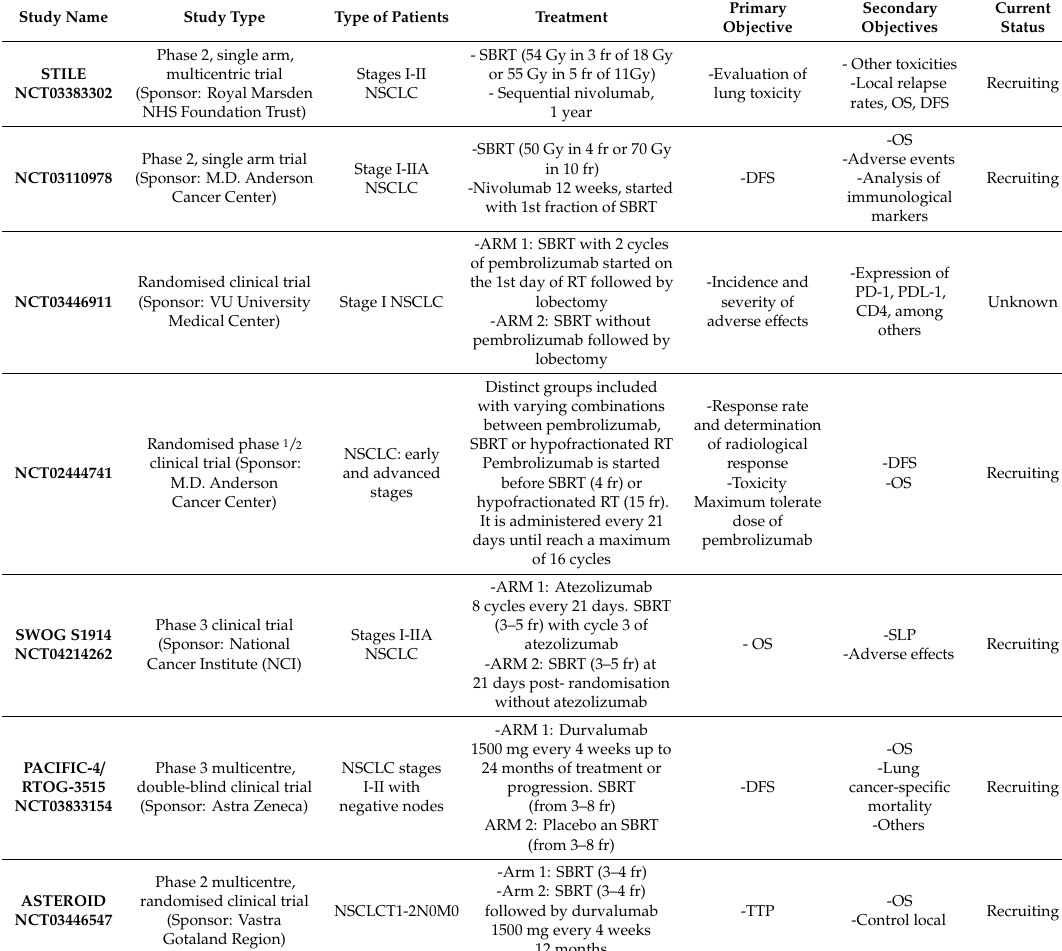
Table 5. Current clinical trials evaluating the combination of immunotherapy and